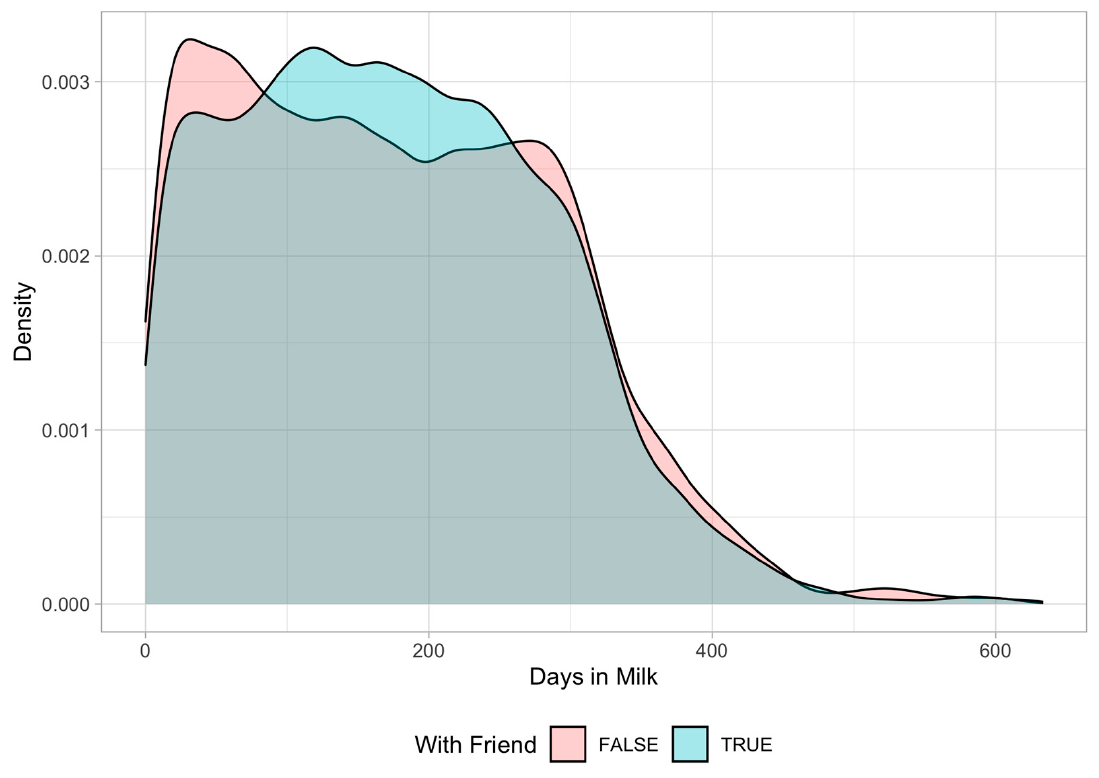
Figure A1. Count of the gate passage per month by pen.